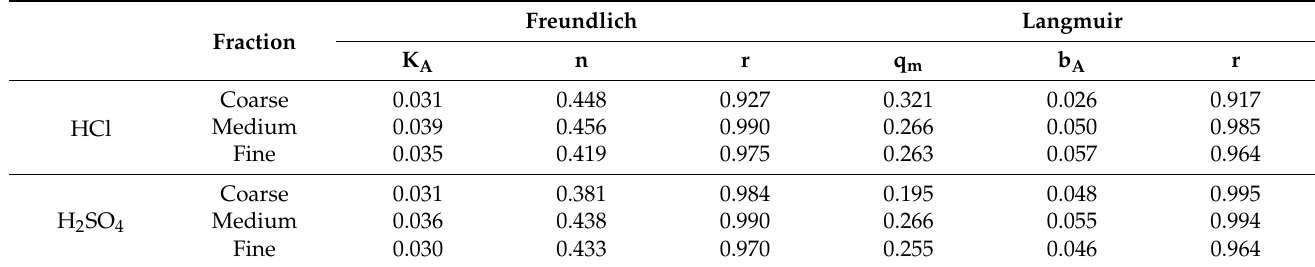
Table 4. PO 43 − adsorption constants according to Freundlich and Langmuir